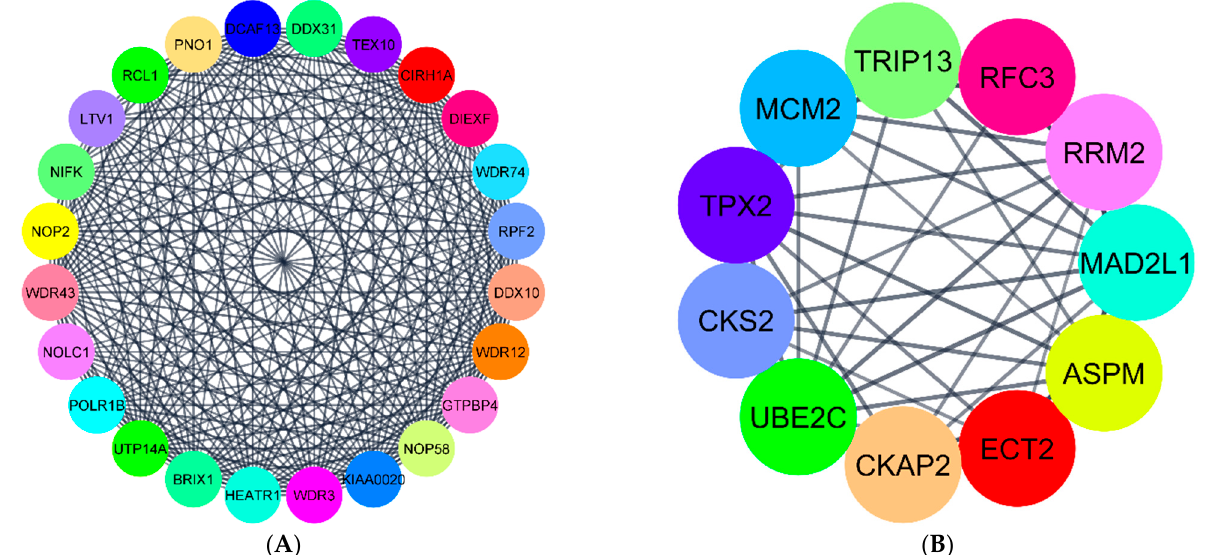
Figure 8. ( A,B ) The most significant modules of DEGs in G3. Cluster1 and Cluster2 were obtained with the MCODE plugin in Cytoscape.